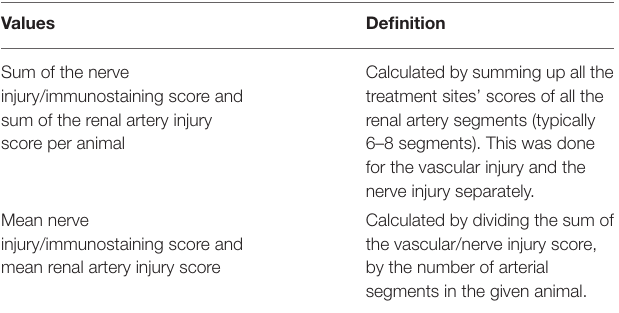
TABLE 3 | Values calculated from the semiquantitative scoring systems.